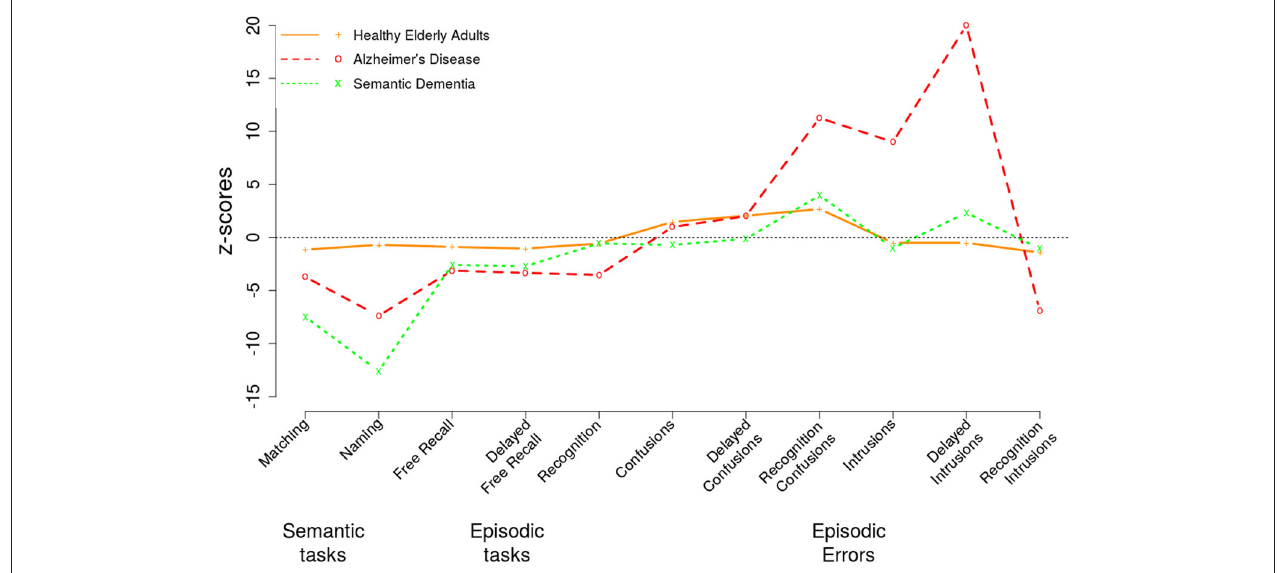
FIGURE 2 | z-scores of healthy elderly adults, patients with Alzheimer’s disease and patients with semantic dementia using data from the young adults as reference across the main scores of the